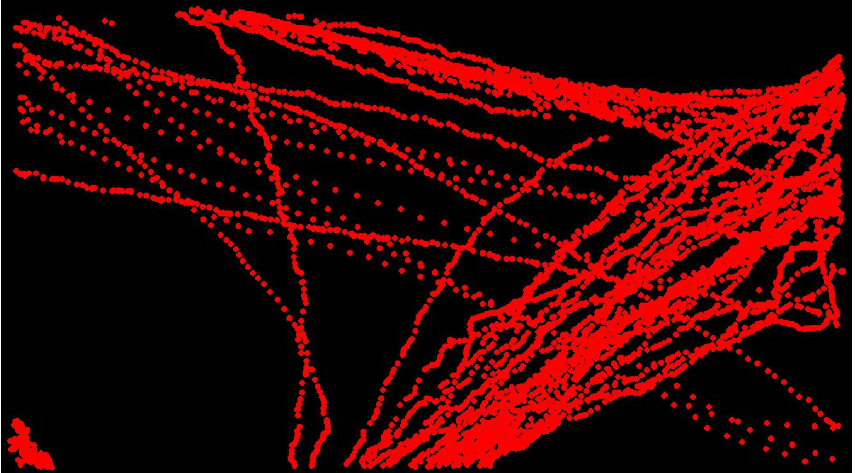
Figure 32. Contrails copied to a mask for analysis.